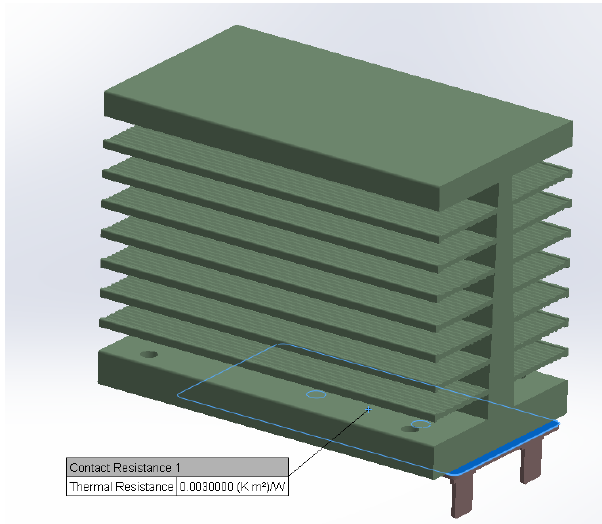
Figure 10. Thermal resistance between thick film heating element and heat sink.